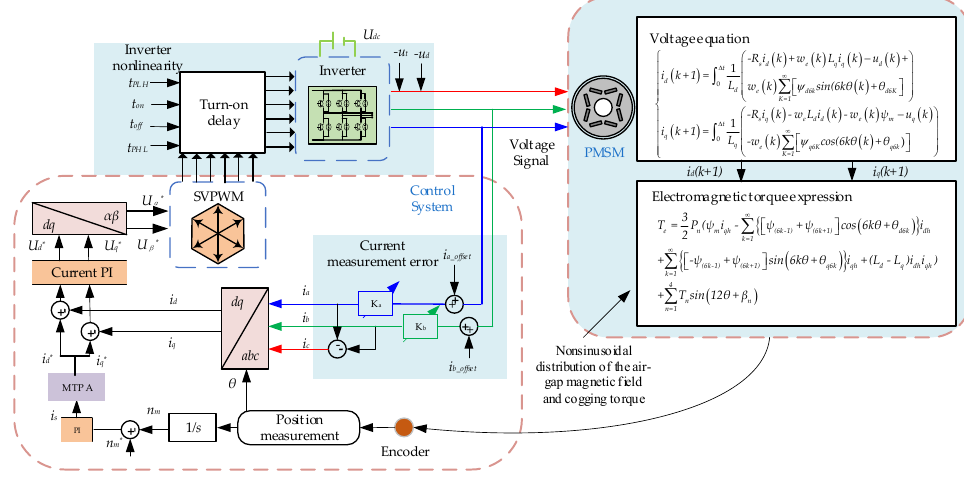
Figure 8. Schematic of PMSM and its control system model considering non ‐ ideal factors.